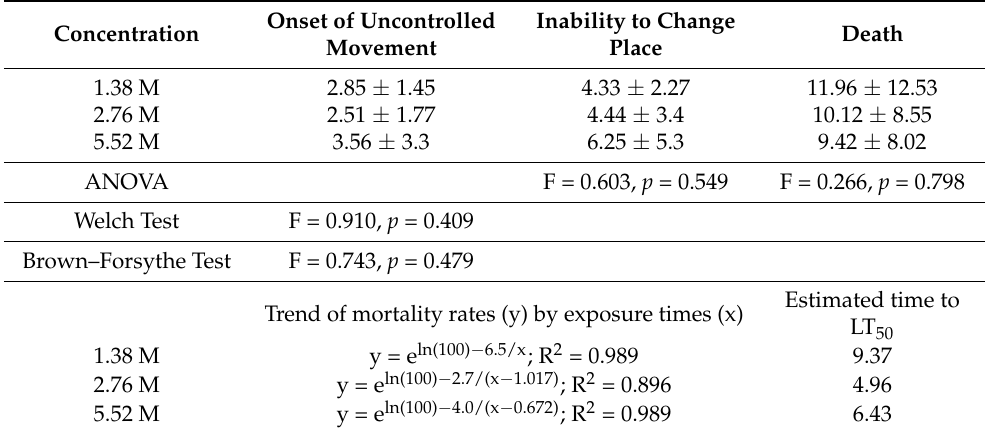
Table 2. Mean ± SD for exposure times (hours) by lithium chloride concentrations in Test I. Onset of Uncontrolled Concentration